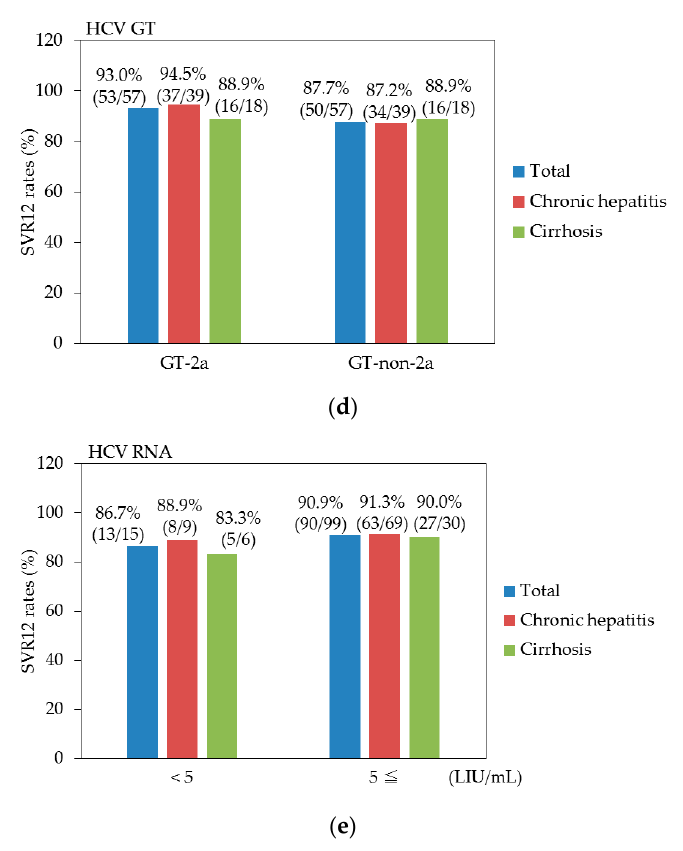
Figure 2. Sustained virologic response at 12 weeks (SVR 12) rates for the various groups with or without cirrhosis. ( a ) Previous interferon treatment; ( b ) Age; ( c ) Gender; ( d ) HCV genotype (GT); and ( e ) HCV RNA viral load. LIU/mL, log IU/mL.